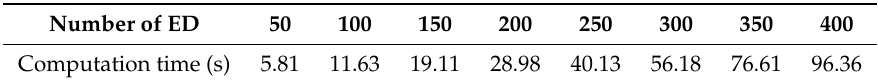
Table 7. Averaged computation time (sec) of spreading factor allocation under conditions listed in = 1.5 I Table 4. W mAh and R = 6000m. Results are obtained by the computer with C MIN